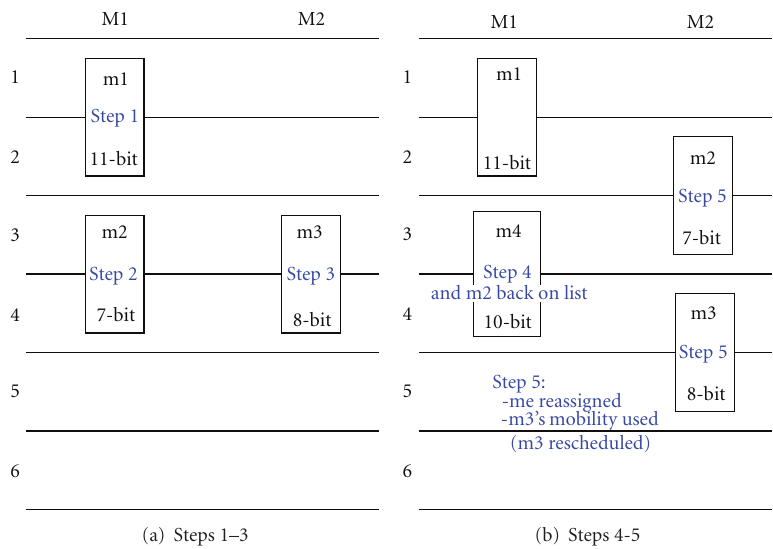
Figure 4: Scheduling with resource assignments with step